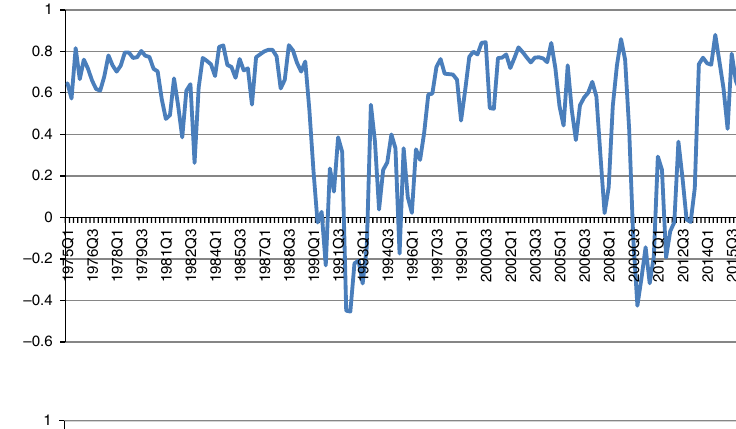
Figure 2. Dynamic conditional correlation between London